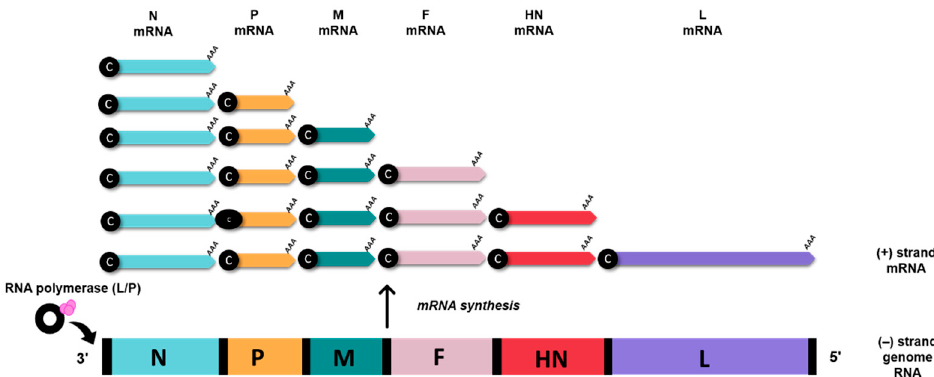
Figure 2. AOaV-1 mRNA synthesis. Viral (-) strand genome serves as templates for the generation of sub-genomic mRNAs. The RNA polymerase (L/P) initiates mRNA synthesis at the beginning of the N gene, near the 3 ′ end of the viral genome. Small black spheres denote 5’ cap (c), AAA denotes poly (A) tail.